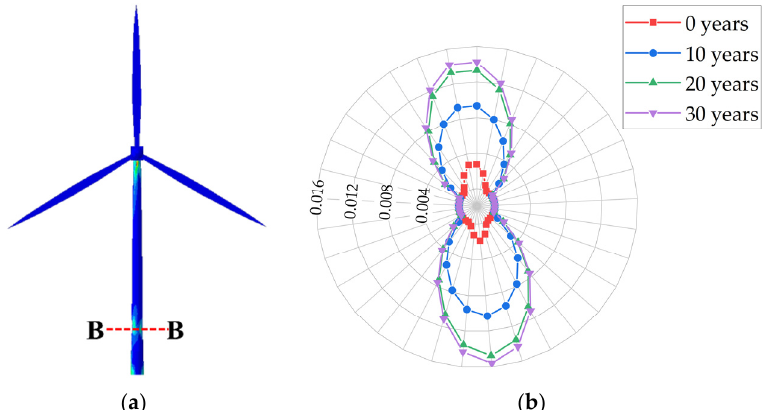
Figure 16. Equivalent plastic strain of corrosion area structure: ( a ) Section position; ( b ) Equivalent plastic strain of section B-B.